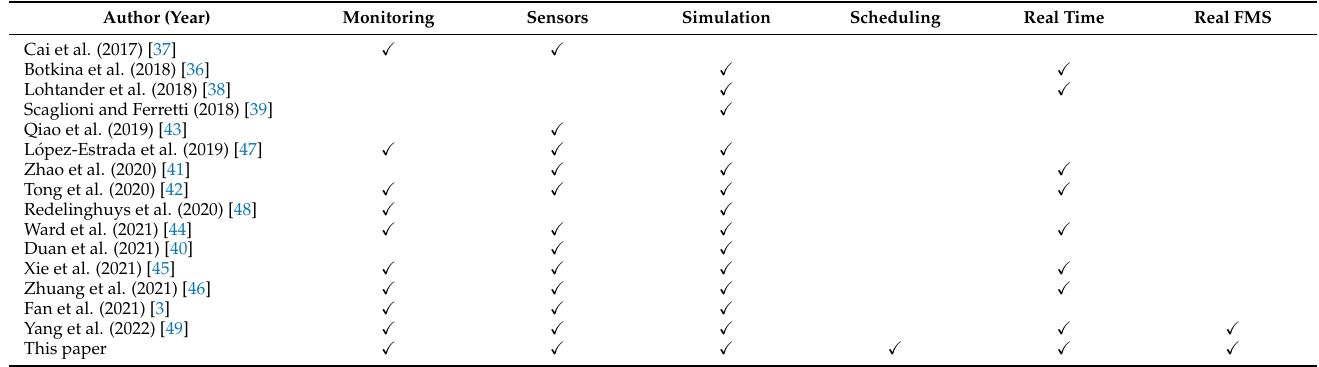
Table 1. A comparative study of the characteristics treated in DT